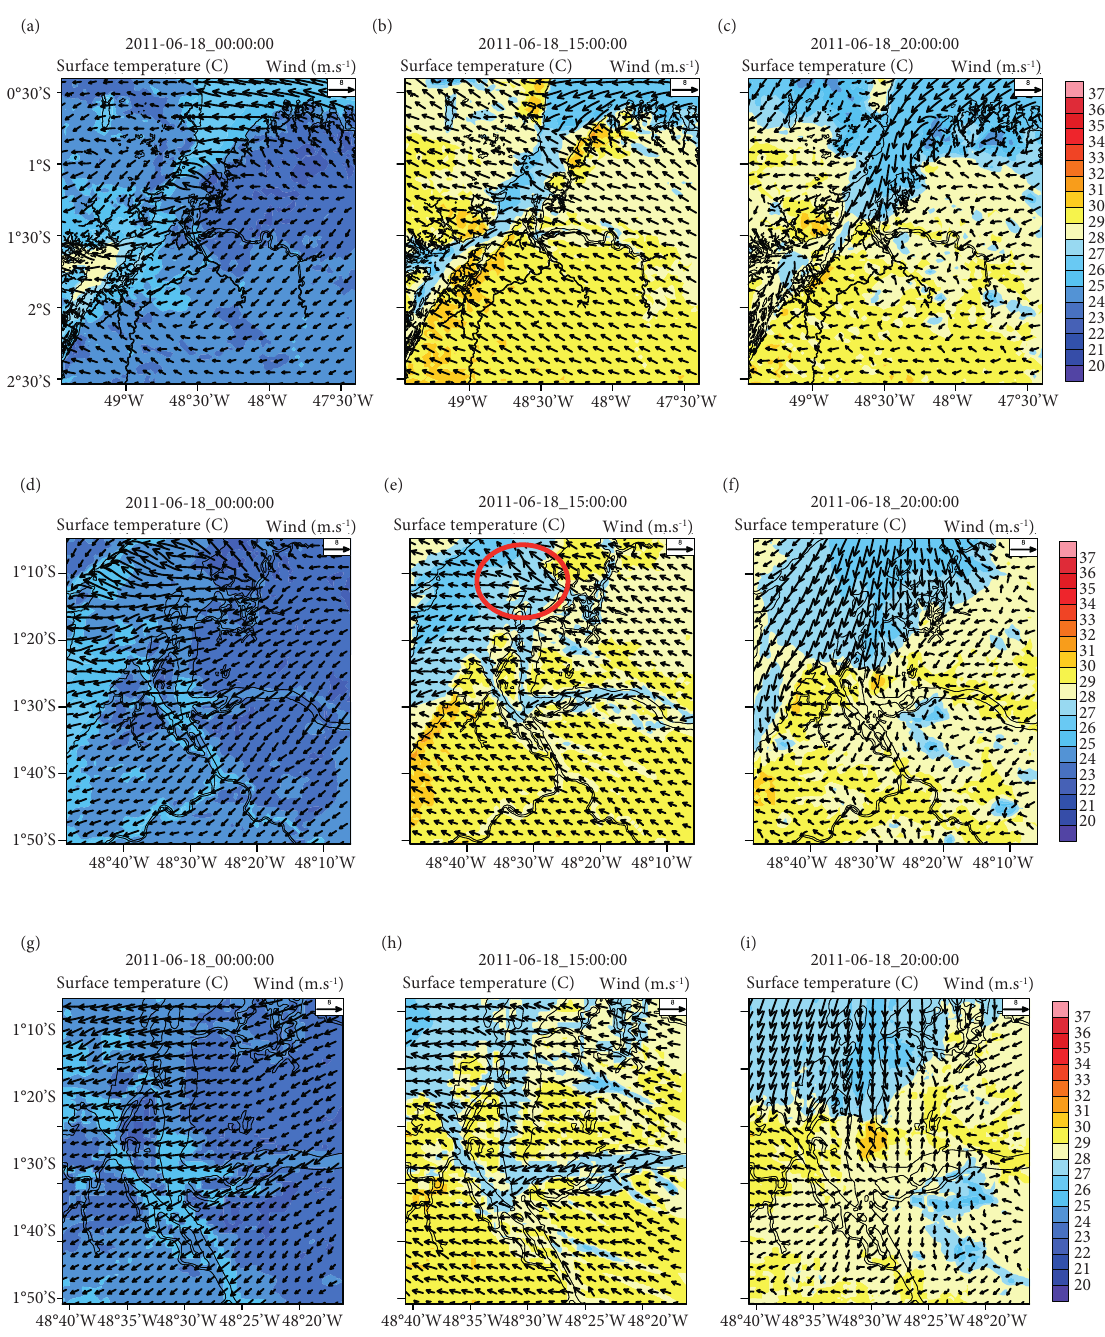
Figure 7. Potential temperature at 2 m and horizontal wind at 10 m in June 18 th , 2011 in domains 2 (a, b, c), 3 (d, e, f) and 4 (g, h, i) at 00 (a, d, g), 15 (b, e, h), and 20 (c, f, i) UTC. The red circle highlights the location of the fan-shaped